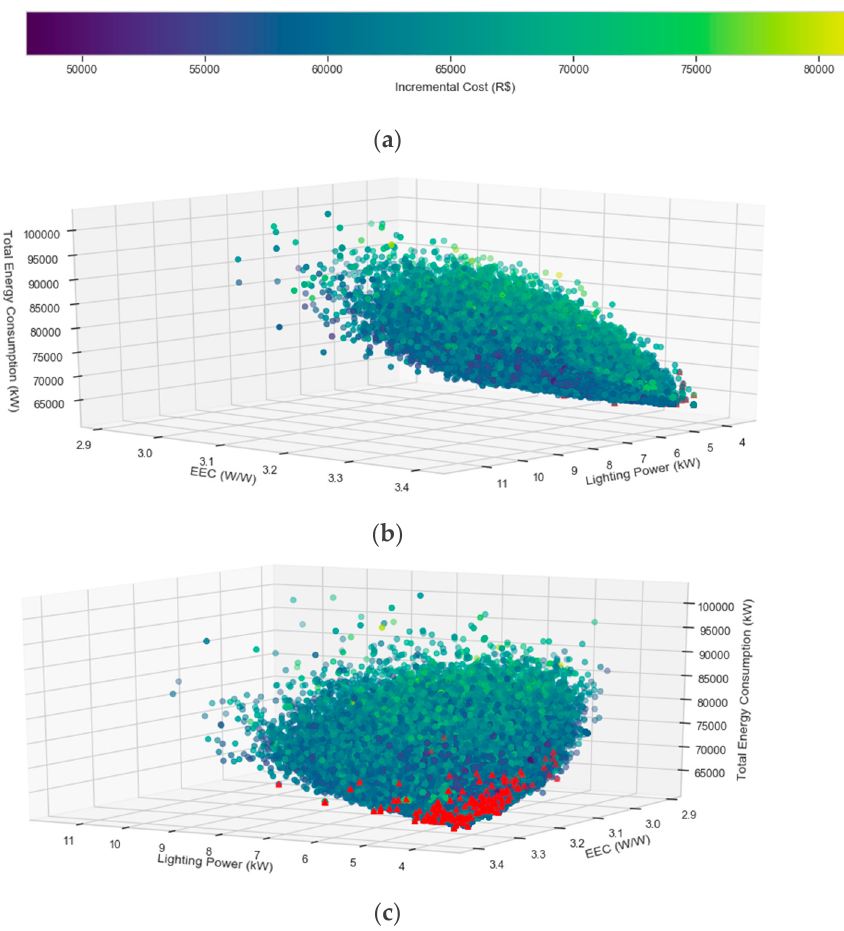
Figure 9. Pareto Curve in the form of a 3D scatterplot ( a ) The color scale of the Incremental Cost Objective, ( b ) Pareto Curve of Case 2—Without Baits and ( c ) Pareto Curve of Case 2—Without Baits turned at approximately 270 ◦